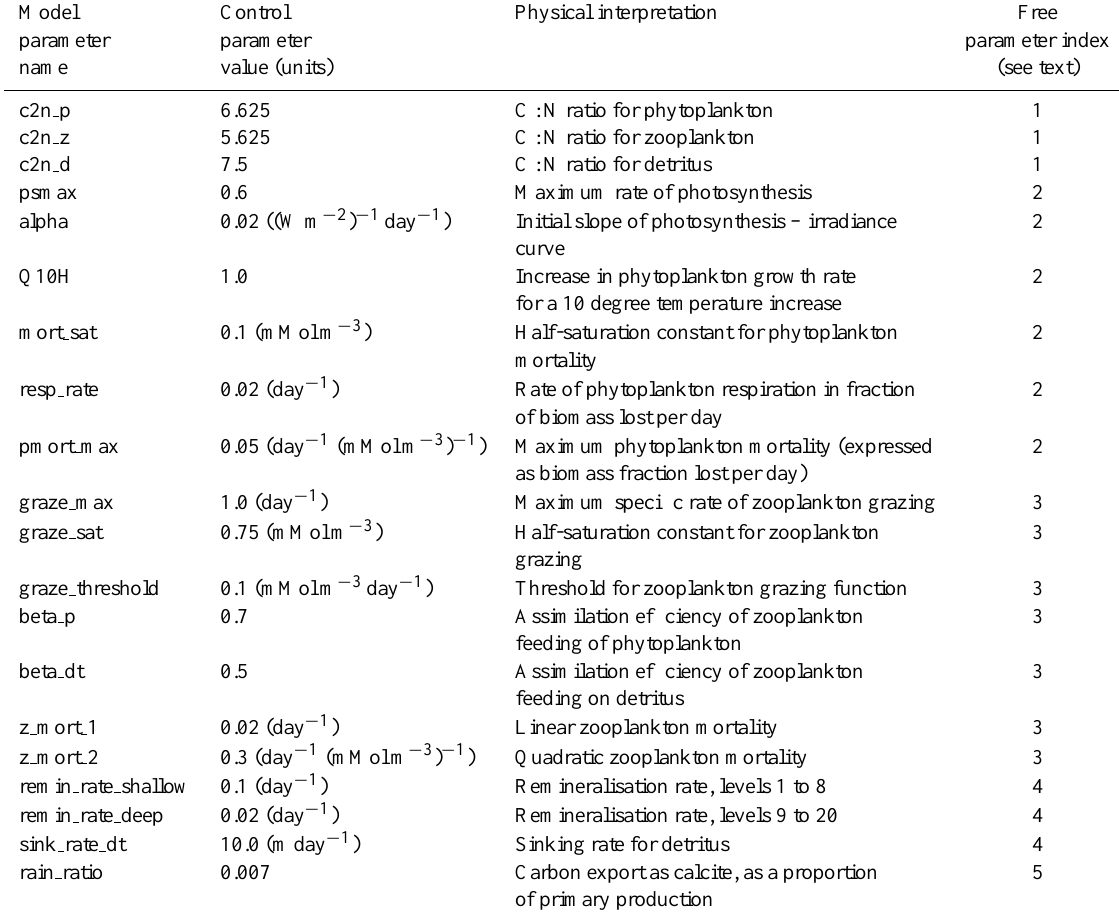
Table 2. Control structural parameters in the HadOCC ecosystem